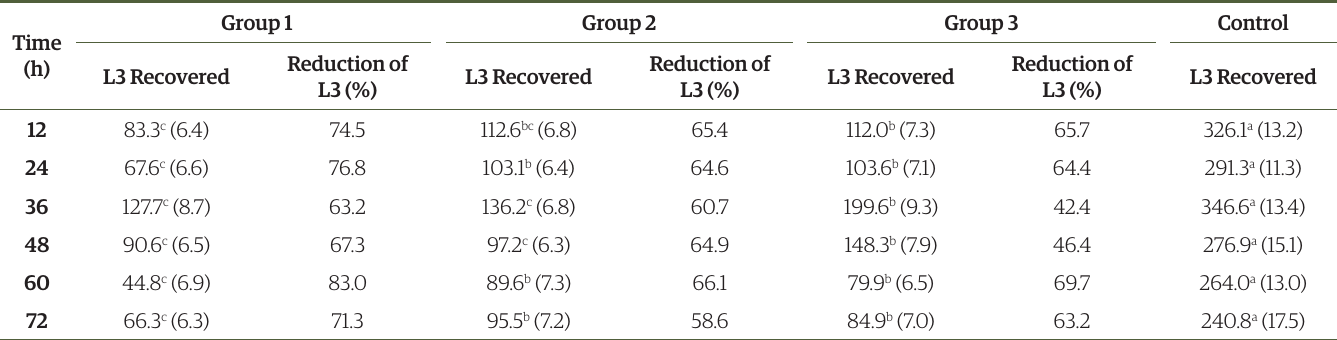
Table 1. Means and standard deviations and percentages of reduction of cyathostomins infective larvae (L3) by the fungi Arthrobotrys musiformis (A144 isolate) and Monacrosporium sinense (SF53 isolate) after passing in sodium alginate matrix pellets through the gastrointestinal tract of horses, and recovered in the feces at times 12, 24, 36 48, 60 and 72 hours after administration of pellets. Experimental groups: Group 1 (100g pellets containing the fungi A144 + SF53); Group 2 (100g pellets containing only the fungus A144); Group 3 (100g pellets containing only the fungus SF53) and group 4 (control, containing pellets without fungi). Results obtained after 15 days of incubation of animal feces with 1000 L3 of cyathostomins, in Petri